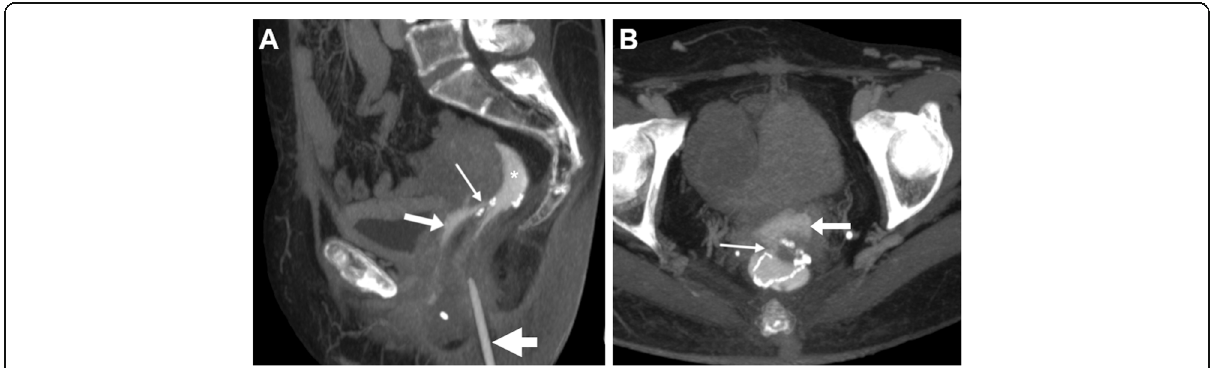
Fig. 3 CT with retrograde contrast medium (CM) enema in VF following low anterior resection (LAR) for rectal carcinoma: maximum-intensity projection (MIP) CT reconstructions ( a , b ) show contrast medium flowing from the diverted stump into the vagina (arrows) through the patent VF (thin arrows). Note rectal catheter (thick arrow in a